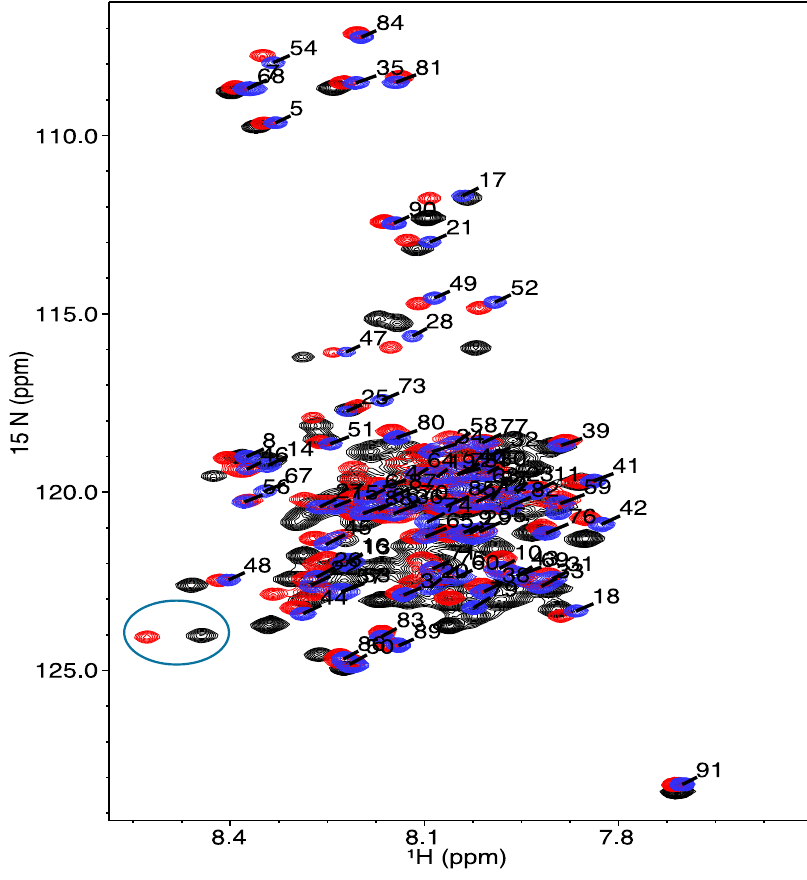
Figure 4. 1 H- 15 N HSQC NMR spectra for COR15A WT and mutants in the presence of 20% TFE. The blue peaks depict the WT protein, the red peaks indicate the single mutant G68A and the quadruple 4GtoA mutant is represented by the black peaks. The peaks are labelled with the residue-specific assignments for the WT protein and the two circled unlabeled peaks at the bottom left represent the G68A residue in the single and quadruple mutant.